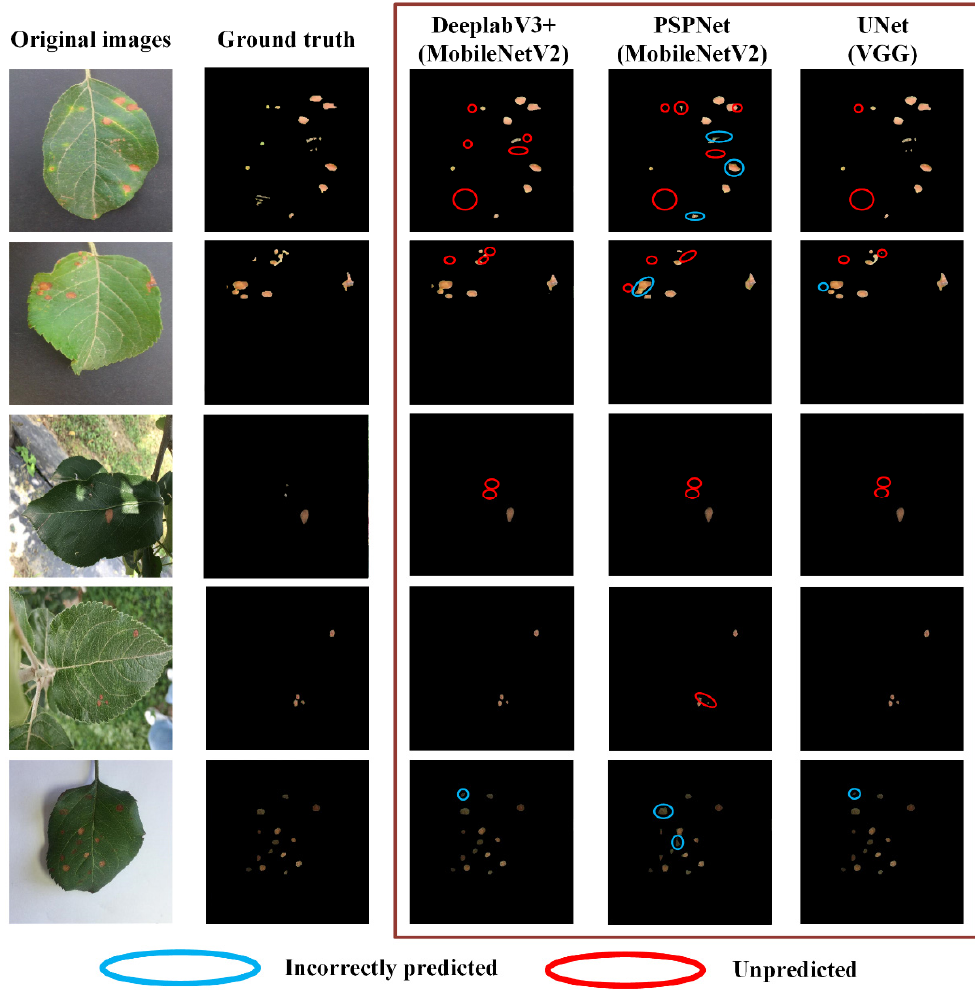
Figure 7. The prediction examples of DeeplabV3+ (MobileNetV2), PSPNet (MobileNetV2) and UNet (VGG) for disease areas: the disease area with the blue circle has only the base truth with no predicted results, which is a false negative (FN), and the red circled disease area only has the predicted result with no base fact, which is false positive (FP).